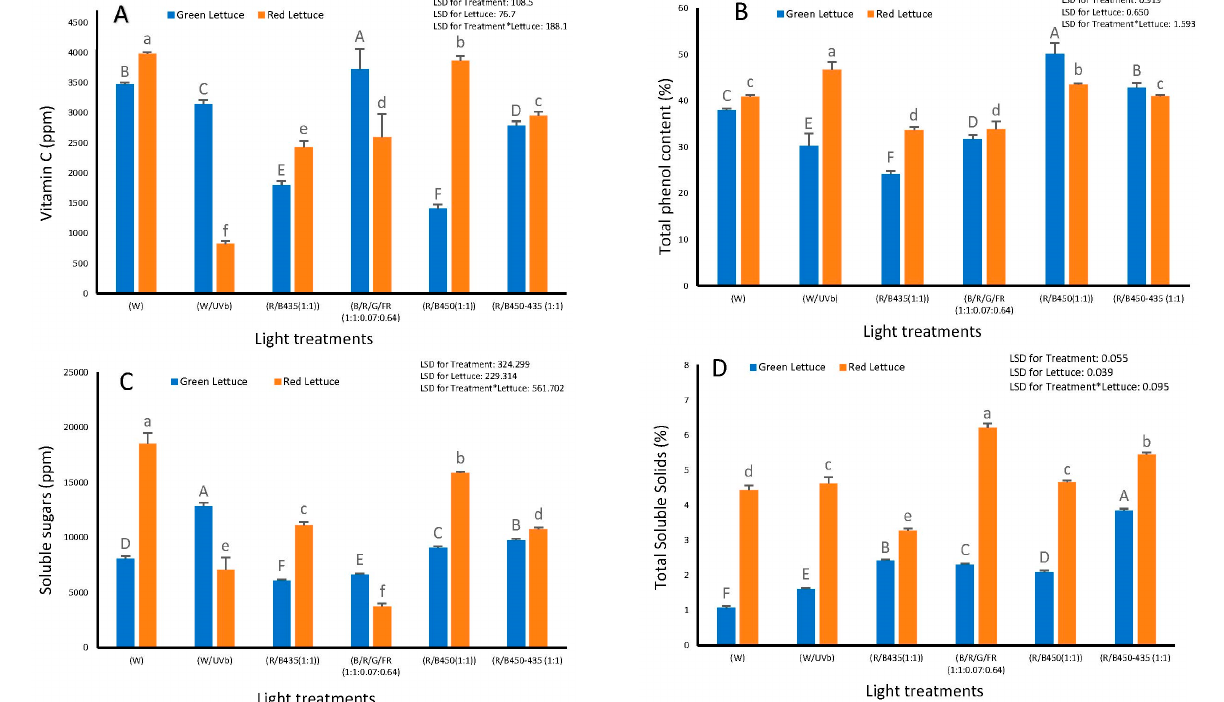
Figure 5. The impact of LED light spectrum on ( A ) vitamin C contents (PPM); ( B ) total phenol content (%); ( C ) soluble sugar content (PPM); ( D ) total soluble solids (%) of green lettuce (Locarno variety) Carmoli variety (red lettuce). Letters indicate significant differences ( p < 0.05) between treatments within each